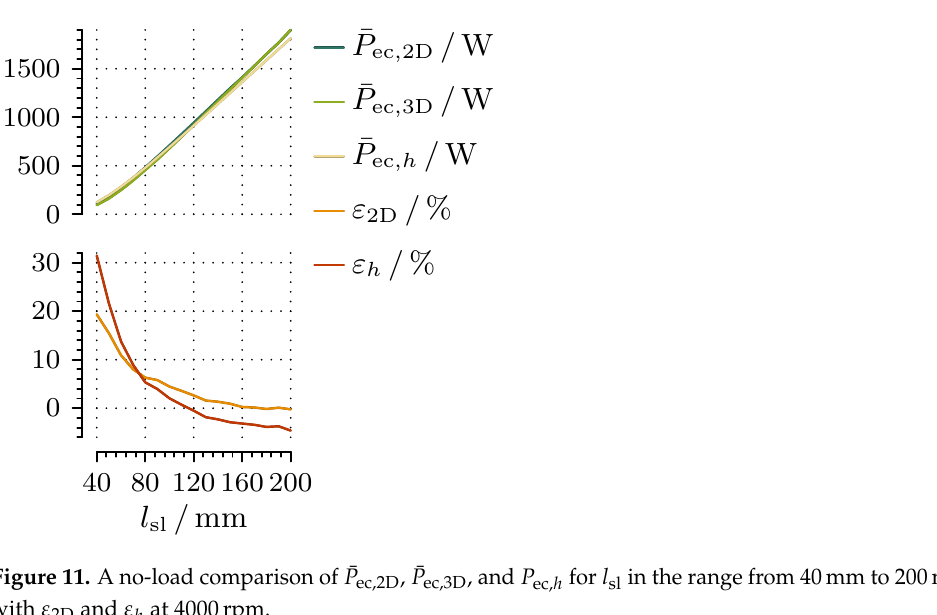
Figure 11. A no-load comparison of ¯ P ec,2D , ¯ P ec,3D , and P ec, h for l sl in the range from 40mm to 200mm with ε 2D and ε h at